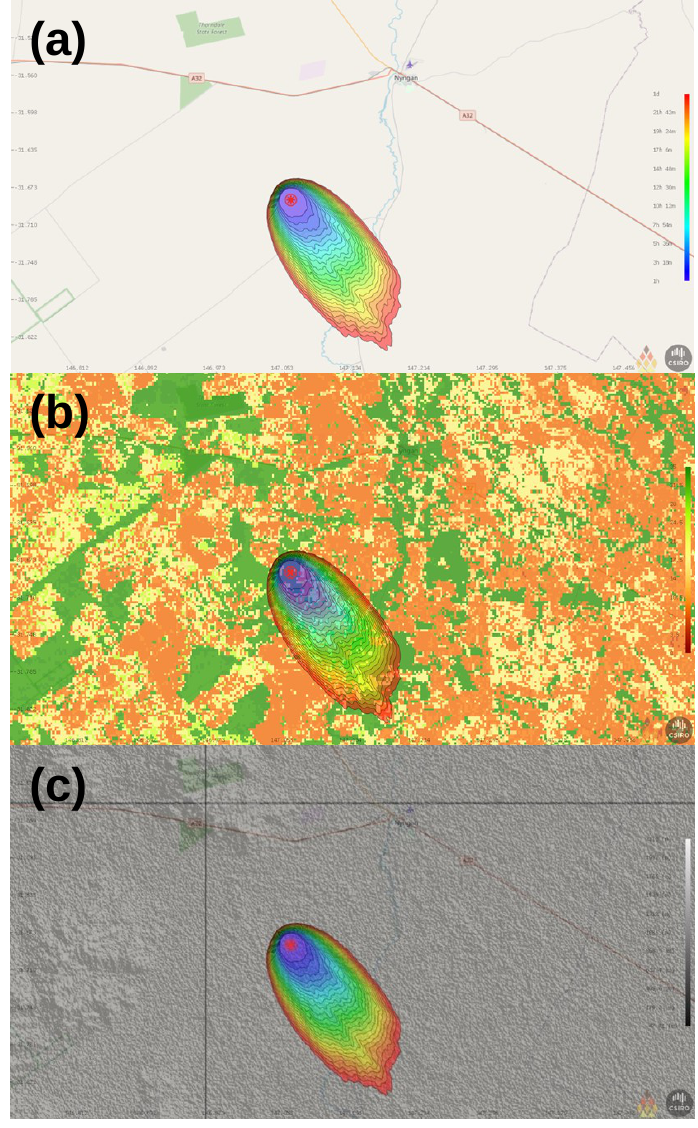
Figure 14. Simulation results of fire spread in the Nyngan region over a 24 h period: ( a ) basemap; ( b ) with vegetation-type basemap; ( c ) with terrain